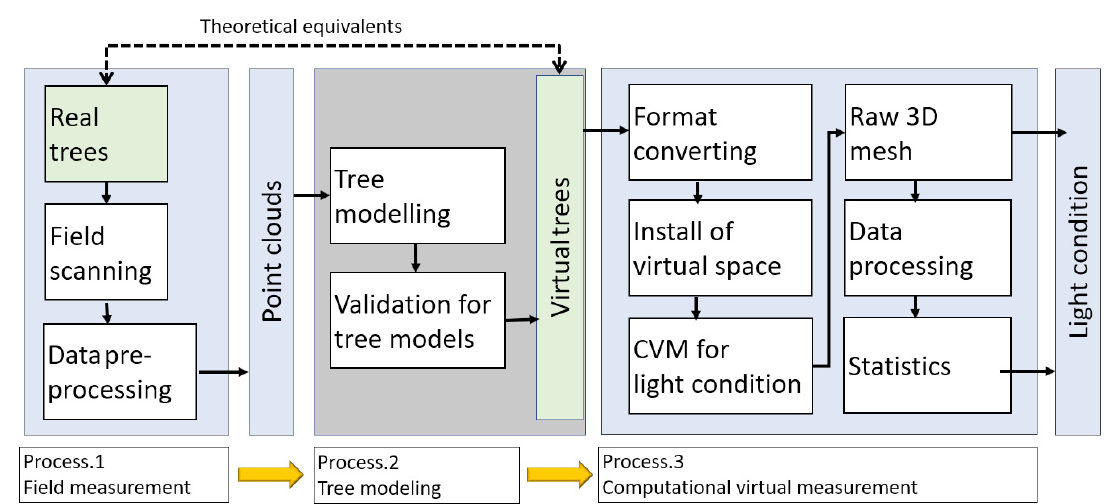
Figure 2. Full workflow of the VMW implementation of light condition measurements.